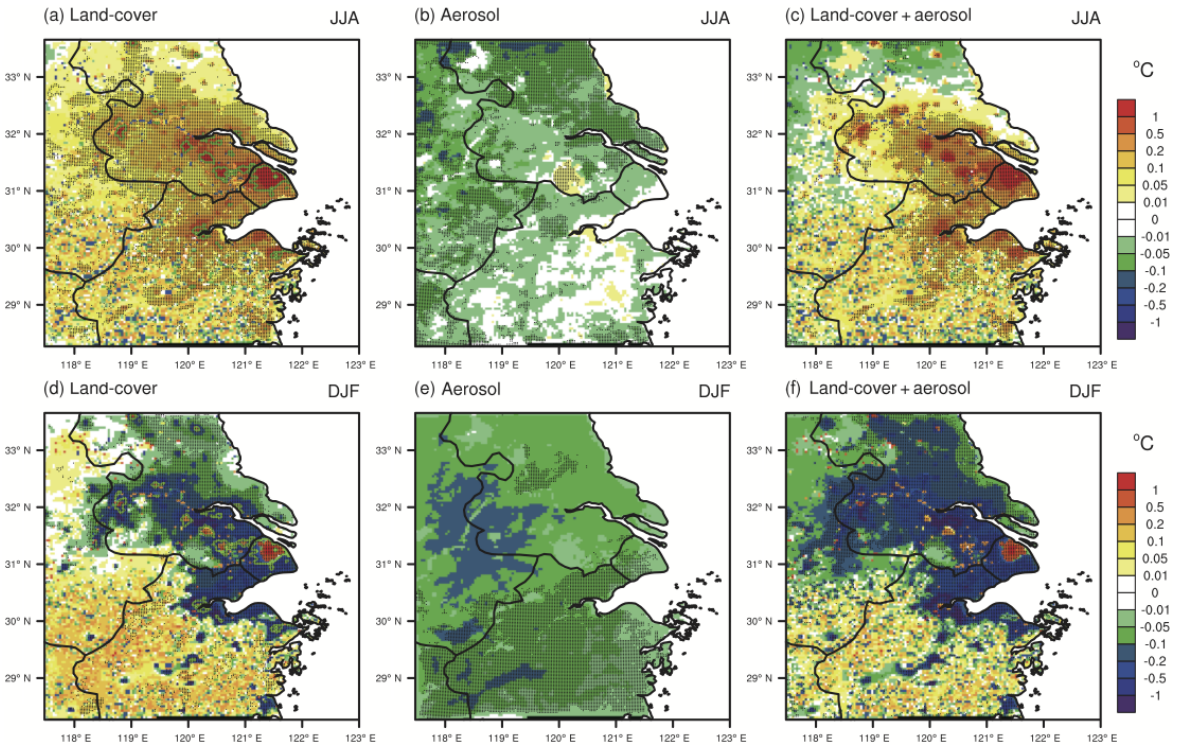
Figure 4. Differences in mean 2m temperature (units: ◦ C) between simulations (a, d) LU06E70 and LU70E70, (b, e) LU70E06 and LU70E70, and (c, f) LU06E06 and LU70E70 for summer (upper panels) and winter (bottom panels). Commercial/industrial/transportation areas are marked with green lines. The black dots mark the area with statistically significant